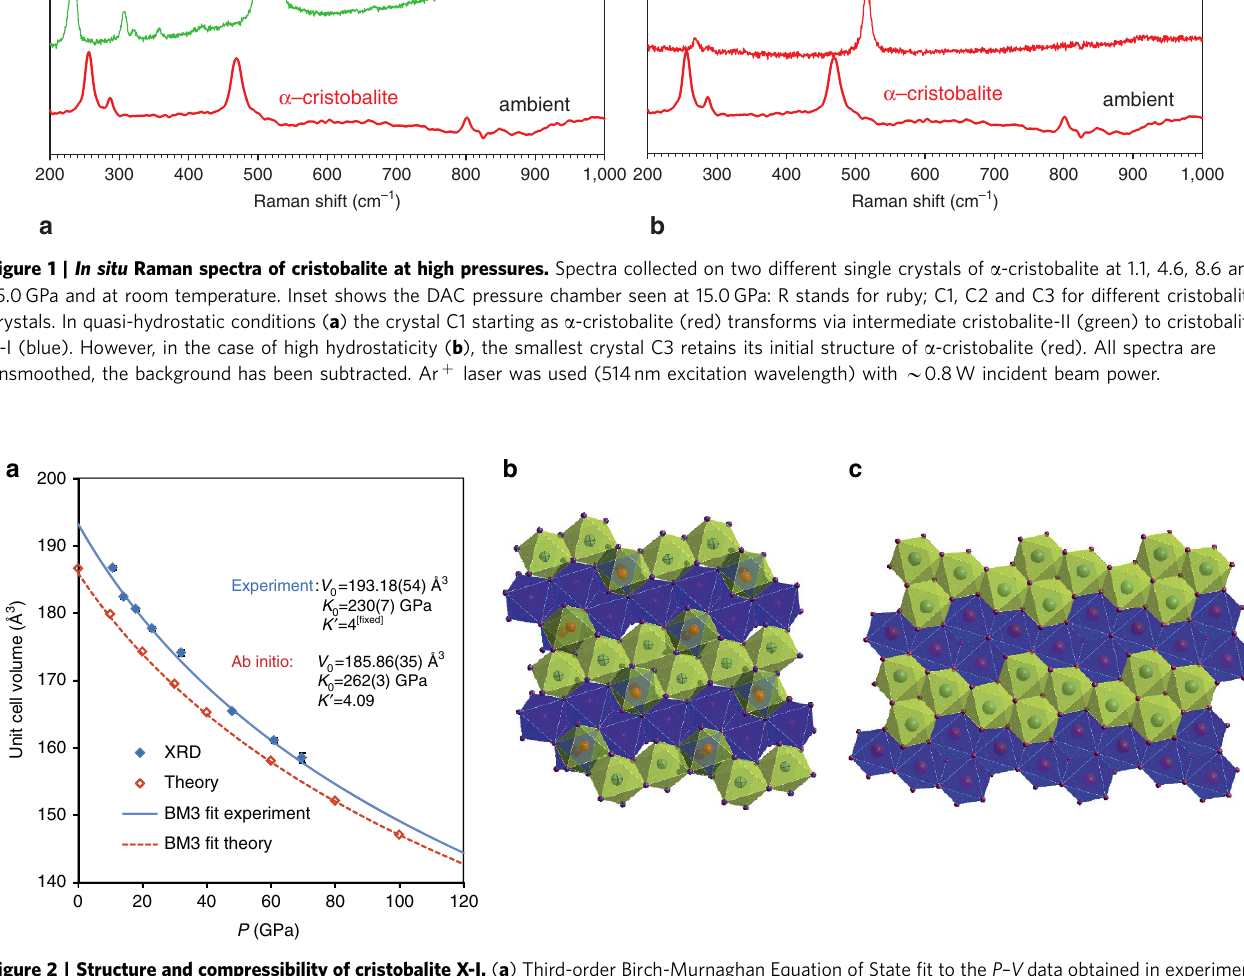
Figure 2 | Structure and compressibility of cristobalite X-I. ( a ) Third-order Birch-Murnaghan Equation of State fit to the P–V data obtained in experiment (blue line) and in ab initio calculations (red line). Exact unit-cell parameters obtained experimentally and theoretically are given in Supplementary Tables 3 and 4. ( b ) [010] projection of the structure of cristobalite X-I as obtained experimentally. The experimental structure contains half-occupied octahedral positions (Si3) shown by red spheres, and fully occupied octahedra (Si1 and Si2) represented by all other spheres, see Table 1. The blue and the green octahedra represent different levels in the structure. A row of three fully occupied octahedra surrounded by two half-occupied octahedra at each side form the ‘5 (cid:2) 2 (cid:2) 2 skeleton’. ( c ) The ordered structure used for model in ab initio calculations. The theoretical structure contains 4 (cid:2) 4 arrangement of the fully occupied octahedra (Supplementary Table 6). The blue and the green octahedra represent different levels in the structure. compression, showing the same pressure band shift as that of the by Dera et al. 10 . The observed a - II transition above 3 GPa a -cristobalite up to B 15 a -cristobalite A (BA-DAC1), as well as the coexistence of a -cristobalite with g ; (3) compression of GPa, far outside its stability field (‘overpressurized’) in BA-DAC1, cristobalite-II and with cristobalite X-I (BA-DAC2) to at least B 14 GPa strongly suggest that the main cause for the onset of the and in crystal C3 of BA-DAC2 is consistent with the observation